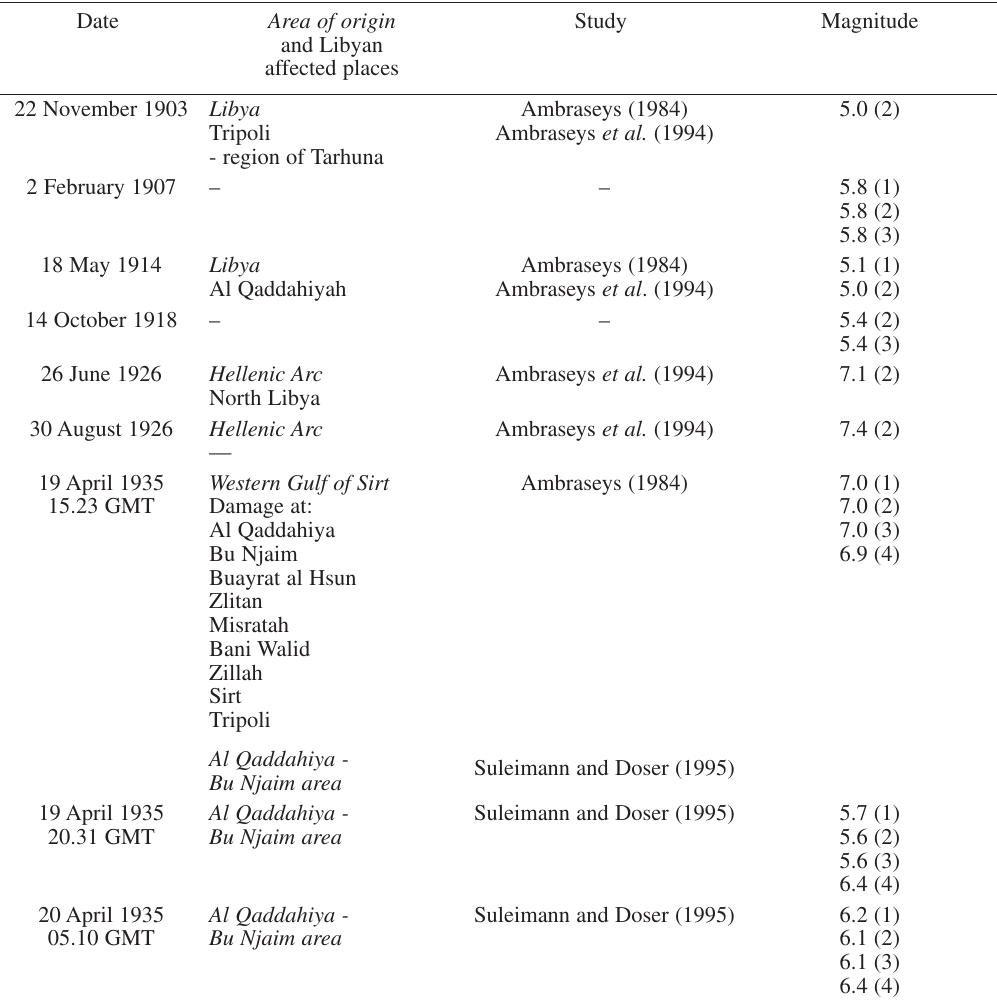
Table II. Earthquakes affecting Libya between 1901 and 1935 ( M ≥